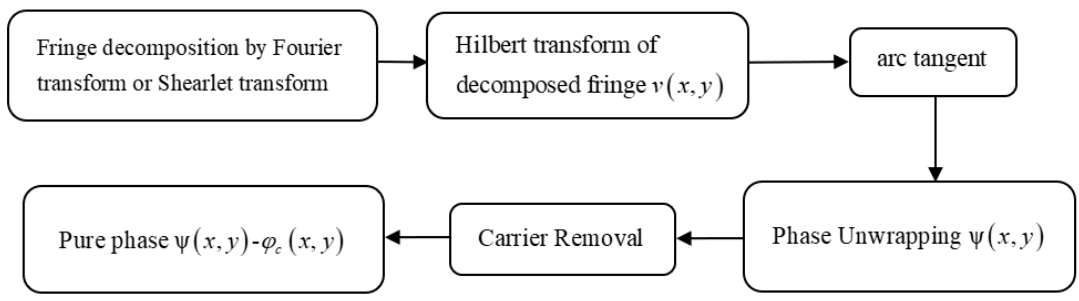
Figure 4. The diagram of phase retrieval by Fourier transform and Shearlet transform.